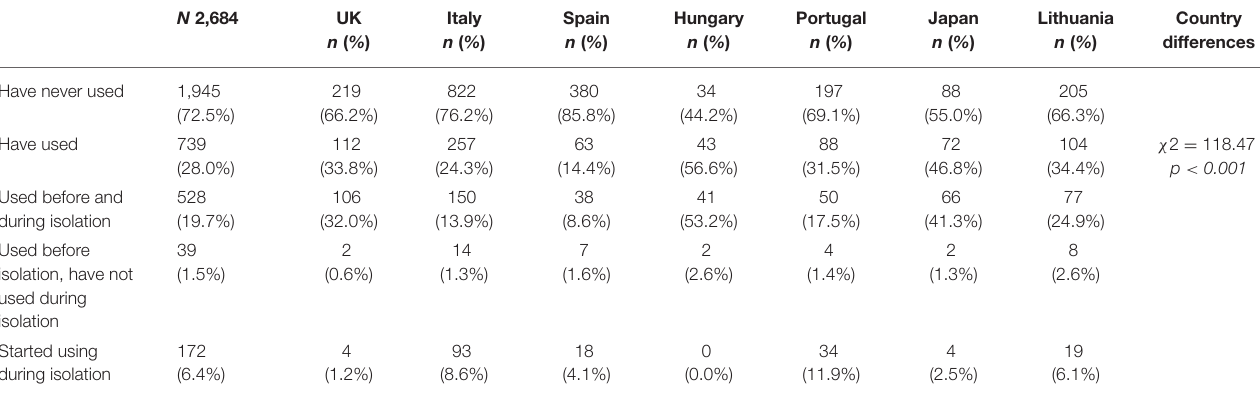
( Table 3 ). In addition, 6.4% of the total sample started